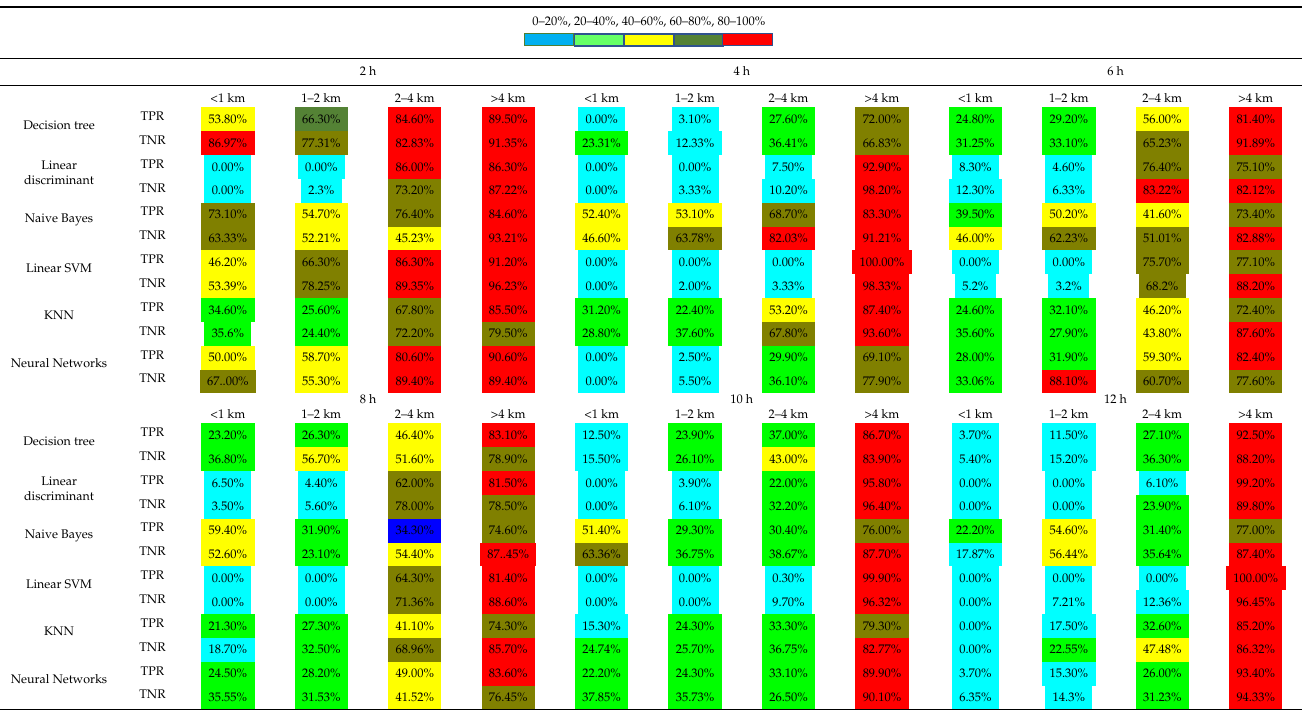
Table 5. Confusion matrix of the six classification algorithms.